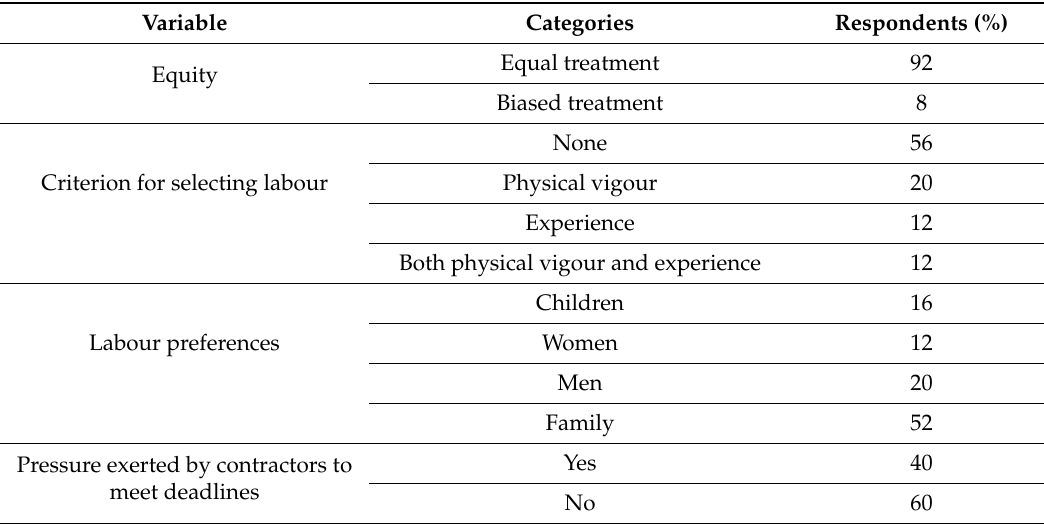
Table 2. Contractors’ behaviour with the NTFP-collecting